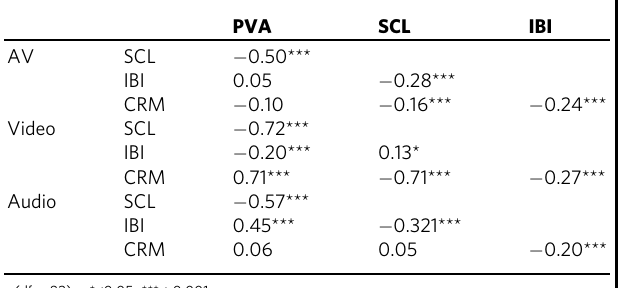
Table 1 By-condition Pearson correlations between the dependent variables across the whole